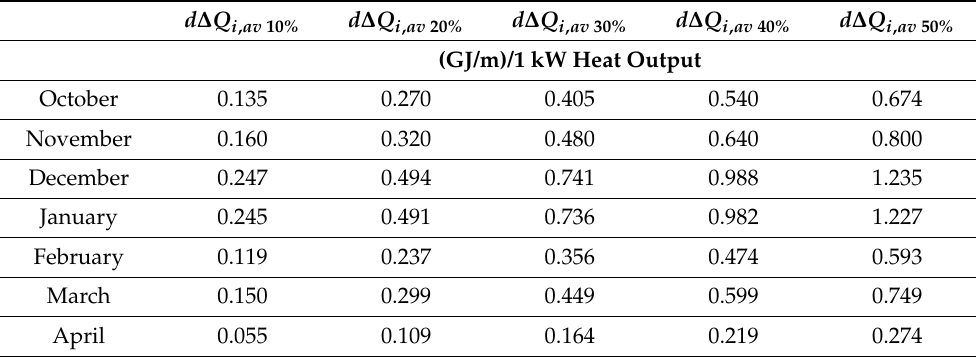
Figure 5 . Nomogram for the selection of maximum hourly potential of heat storage and maximum potential for heat transfer to the heating network .